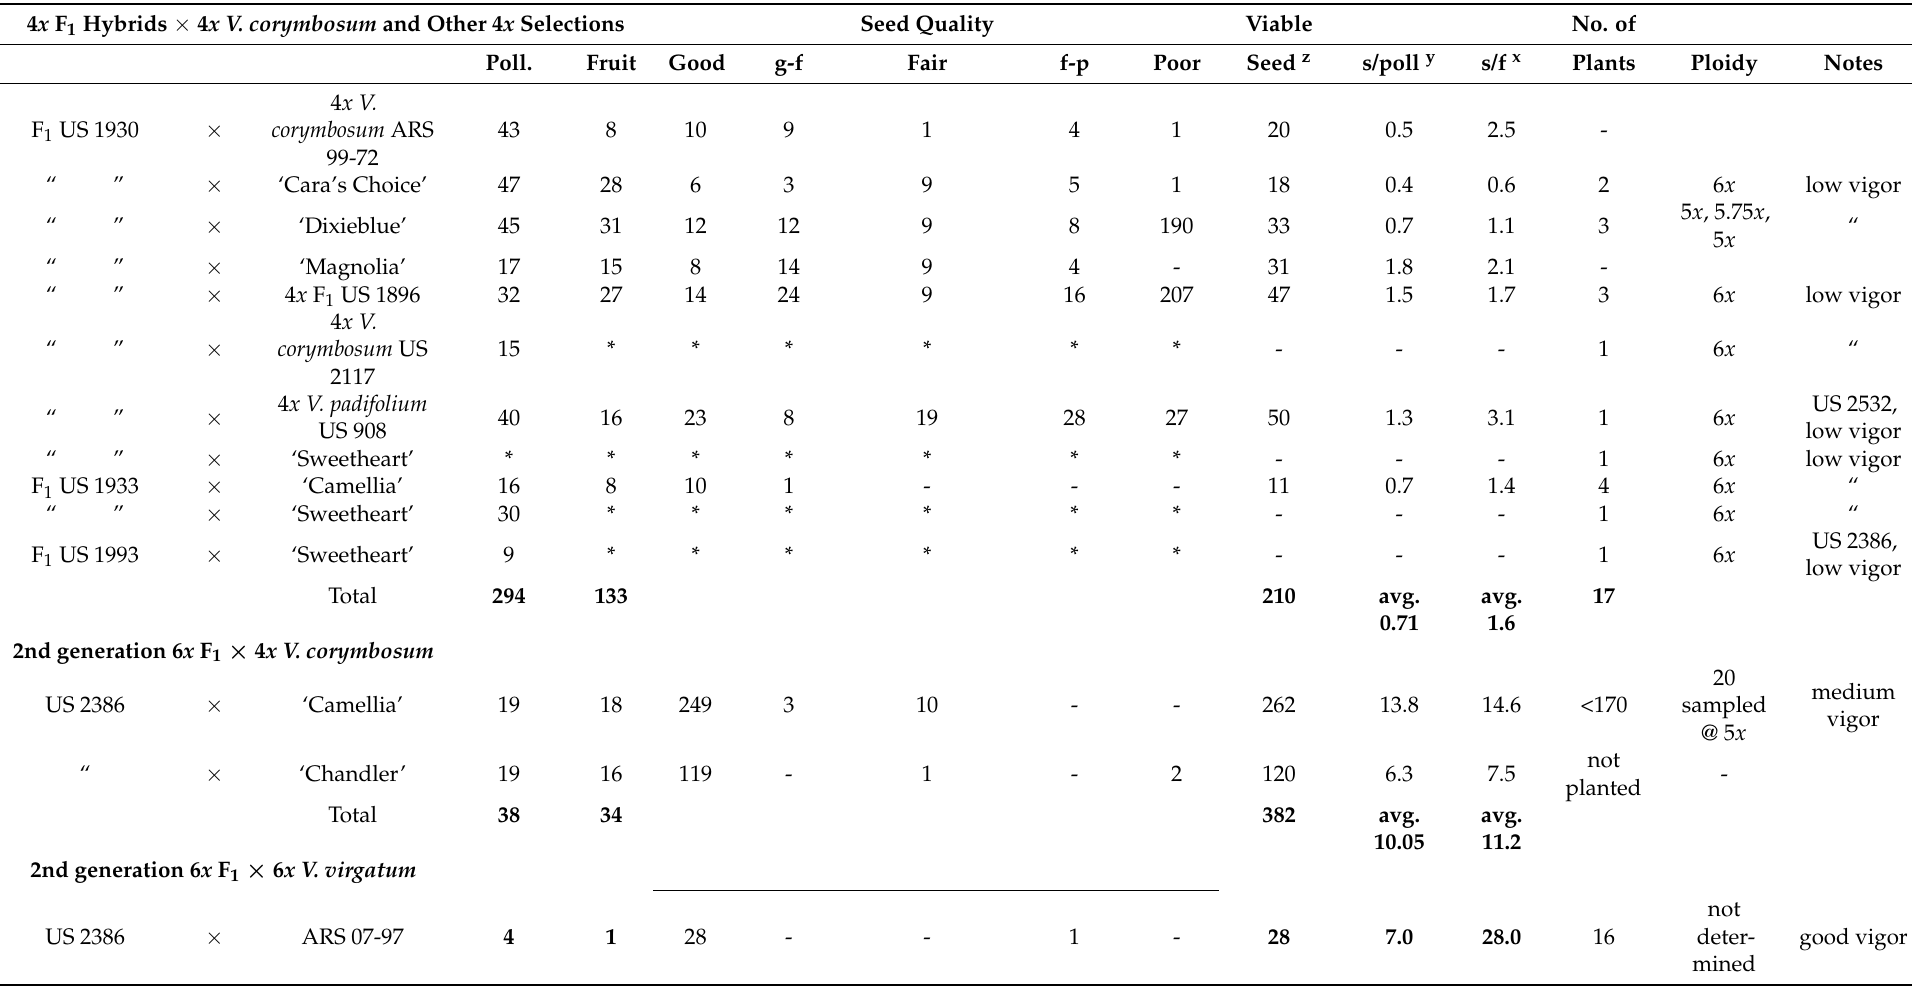
Table 1. Crosses of 4 x V. meridionale — V. vitis-idaea hybrids (US 1930, US 1933, US 1993) as females with 4 x males, and an advanced generation 6 x hybrid (US 2386) as female with 4 x and 6 x